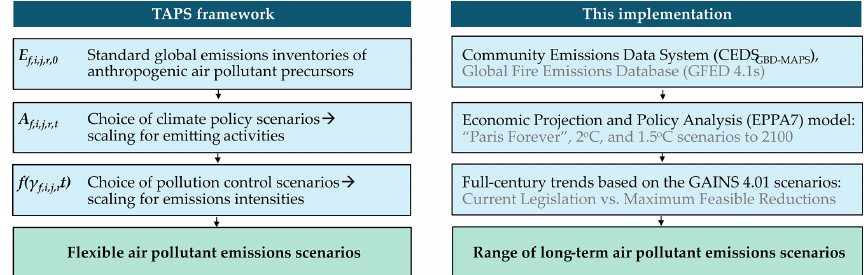
Figure 1. Summary of the Tool for Air Pollution Scenarios (TAPS) framework and implementation here, based on climate policy scenarios in EPPA7 and pollution control scenarios from the Greenhouse Gas–Air Pollution Interactions and Synergies (GAINS) model. Emissions trends are specific to each fuel f , pollutant species i , sector j , region r , and time point t in the inventories and EPPA7 scenarios